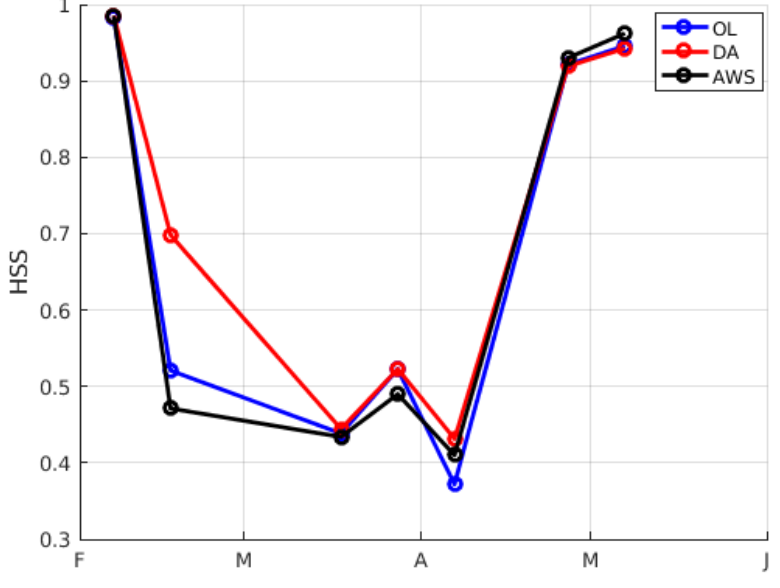
Figure 15. Temporal evolution of HSS (compared to Sentinel-2 SCA maps) for open loop (OL), data assimilation (DA) and with automatic weather stations (AWS)